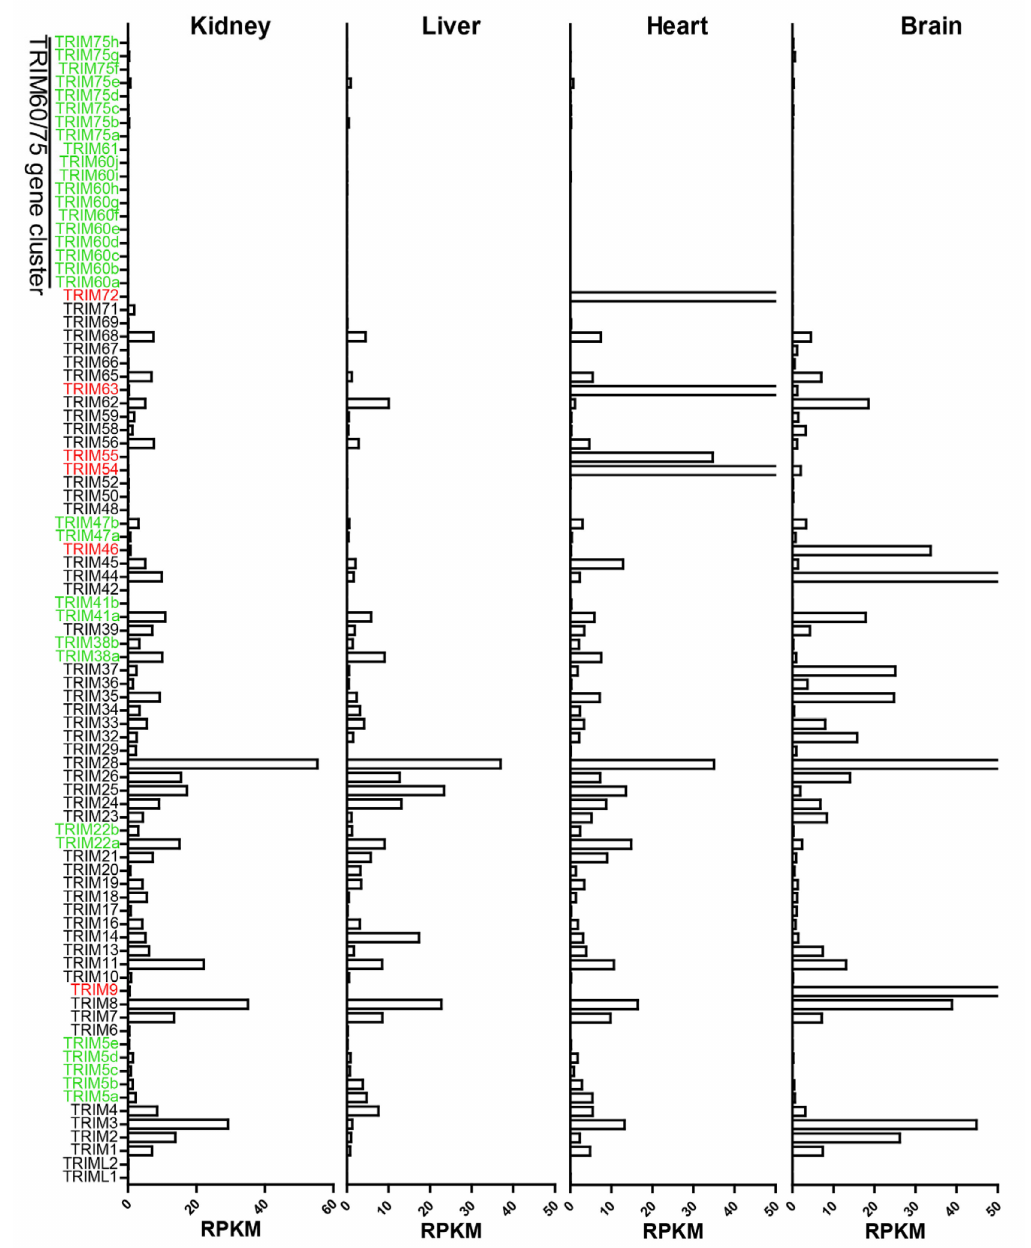
Figure 3. RPKM of bat TRIM genes in transcriptome data from Myotis myoti tissues. The duplicated genes are marked in green, and the tissue-specific expressed genes are marked in